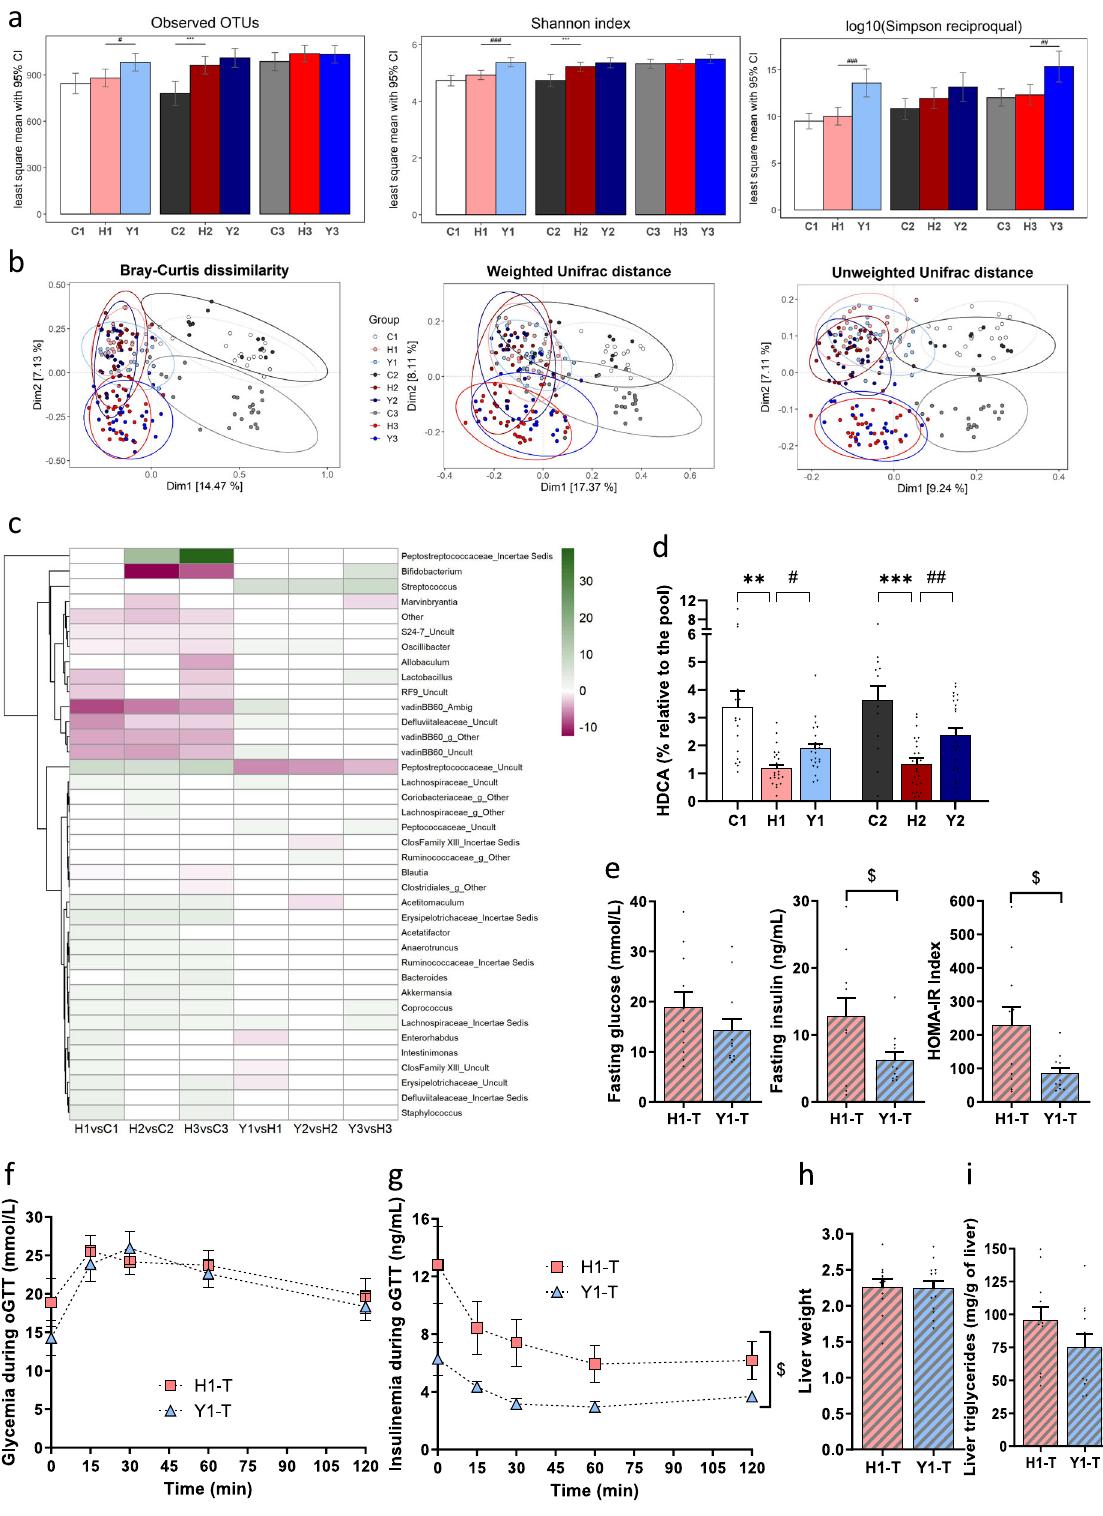
phenotypes observed in animals consuming yogurt compared to controls submitted to FMT from H-fed donors as revealed by lower fasting insulinemia and HOMA-IR values ( p < 0.05) (Fig. 3e) as well as reduced GSIS during the oGTT (Fig. 3f, g). However, no differences were observed on liver weight whereas a numerical but not signi fi cant reduction was seen on hepatic triglyceride levels (Fig. 3h, i). The bene fi cial effect of FMT from